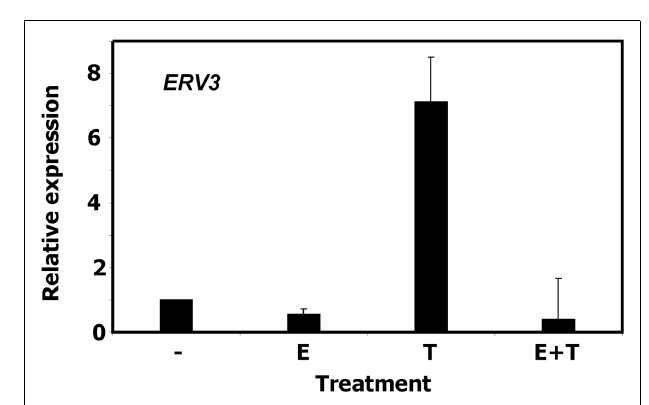
FIGURE 3 | Expression of ERV3 in P439-6 cells . Expression of ERV3 was analyzed in P439-6 cells under different culture conditions by qRT-PCR. Cells were cultured in the absence or presence of estrogen (E) and/or tetracycline (T). Presented are means and standard errors from duplicate determinations. For comparative analysis, beta actin was used as housekeeping control and the mean of P439-6 cells cultured in medium was set as